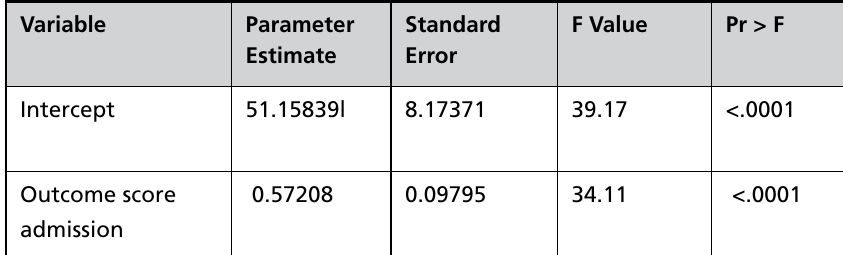
table 5: summary of remaining variable in the Multiple predictor